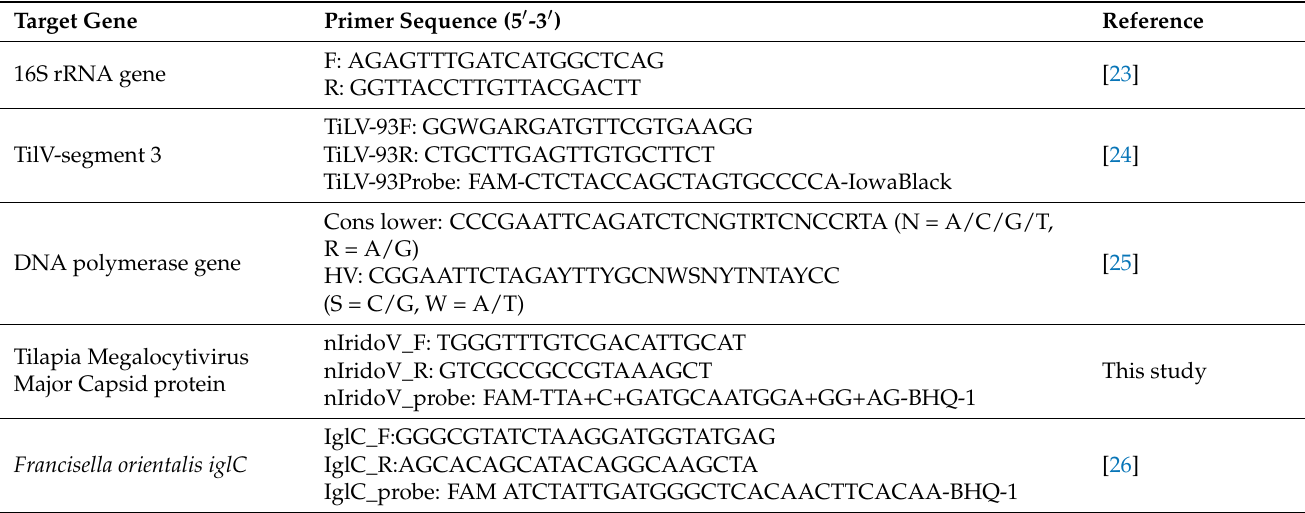
Table 1. PCR primers and probes used in this